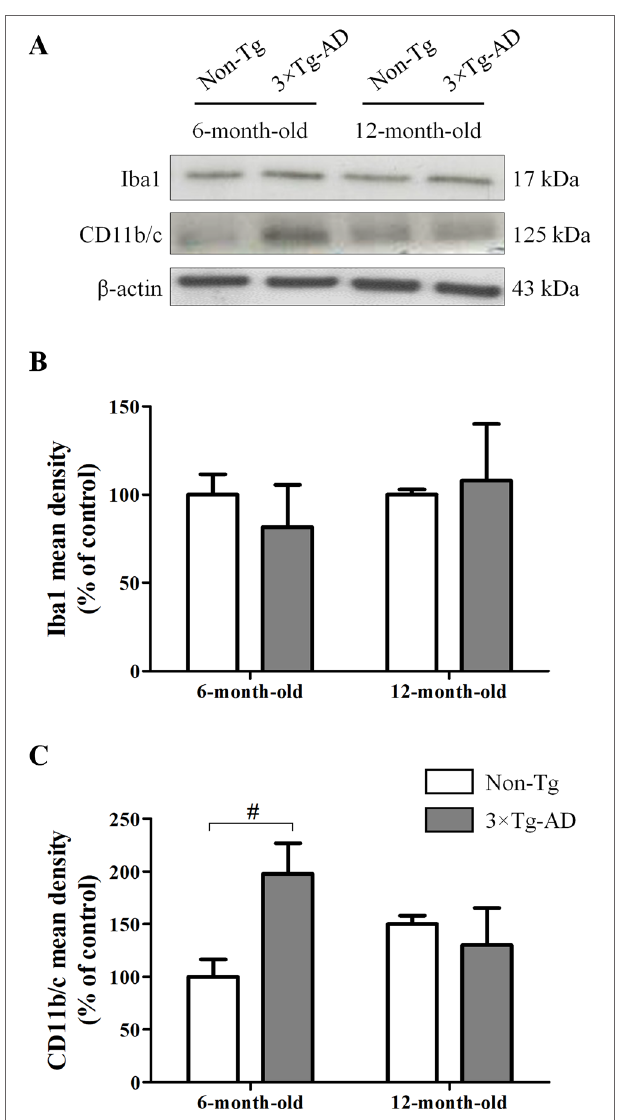
FIGURE 2 | Effects of aging on hippocampal microglia of 3×Tg-AD and Non-Tg mice. (A) Representative Western blots for Iba1 and CD11b/c and (B , C) densitometric analyses normalized to β -actin loading control. Results are expressed as means ± SEM of percentage of controls (6-month-old/ Non-Tg) (N = 3, in triplicate). Statistical analysis was performed by two-way ANOVA followed by Bonferroni’s post hoc test ( # p < 0.05, 6-month-old/ 3×Tg-AD vs